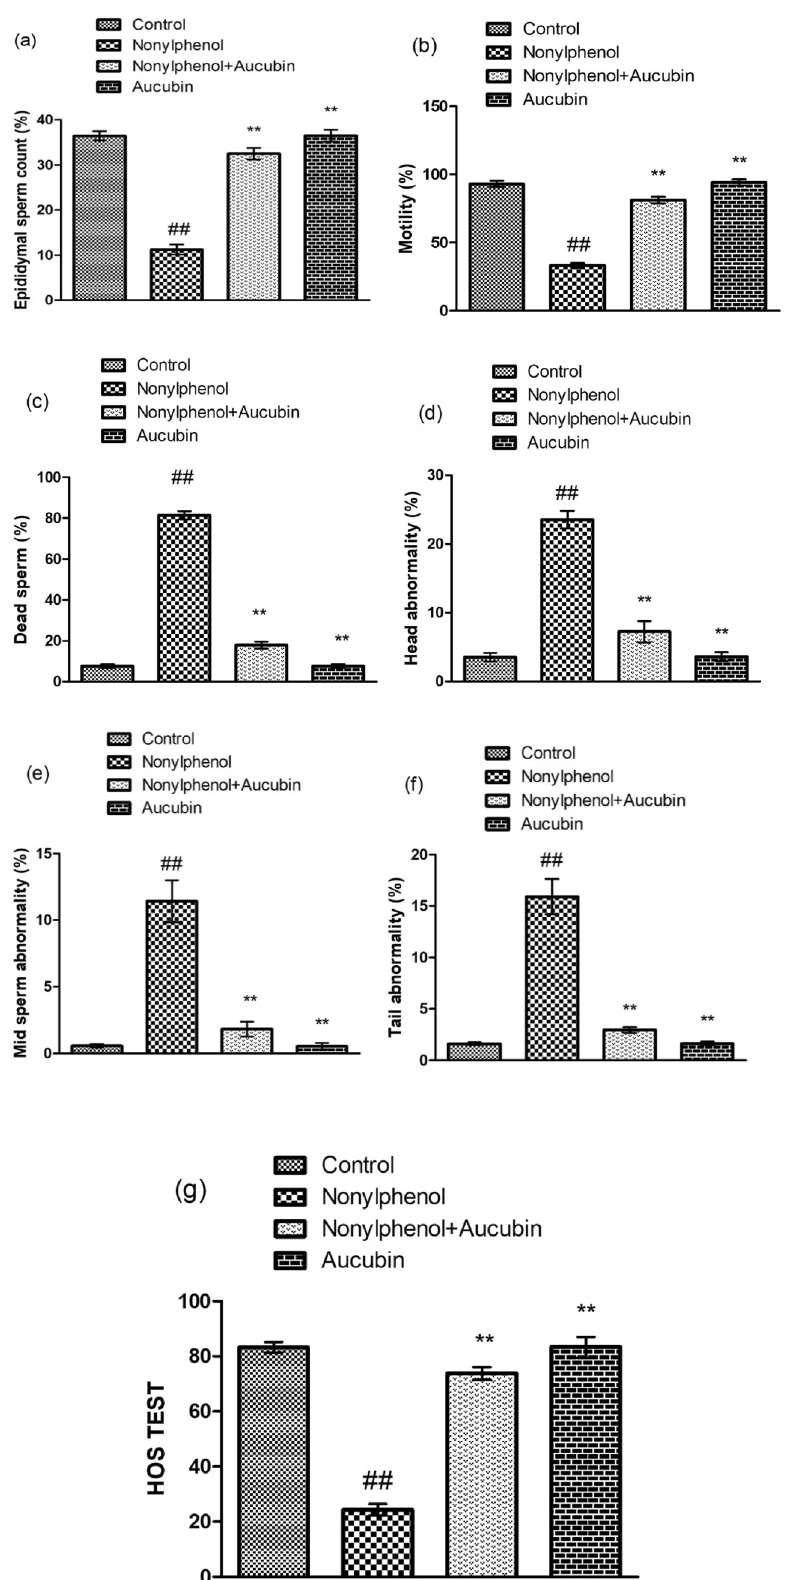
Figure 2. Effect of NP and AU on Spermatogenic-indices: epididymal sperm count ( a ), motility ( b ), dead sperm ( c ), head abnormality ( d ), mid sperm abnormality ( e ), tail abnormality ( f ), and sperm membrane integrity by hypo-osmotic swelling (HOS) test ( g ). Values are expressed as Mean ± SD (12 rats per group). Significant differences displayed as ## P < 0.01 compared to control; ** P < 0.05 compared to NP-treated